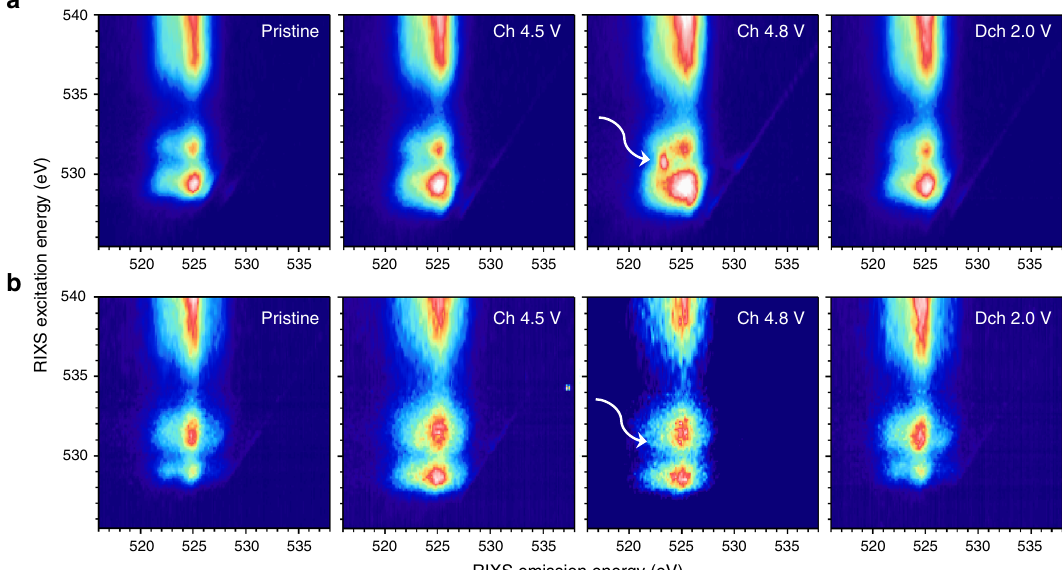
Fig. 5 Electronic structures of O as probed by RIXS. O K-edge RIXS maps of a LNMO and b LNRO electrodes at different states of charge. The while arrow points to the speci fi c oxygen redox state that is absent in